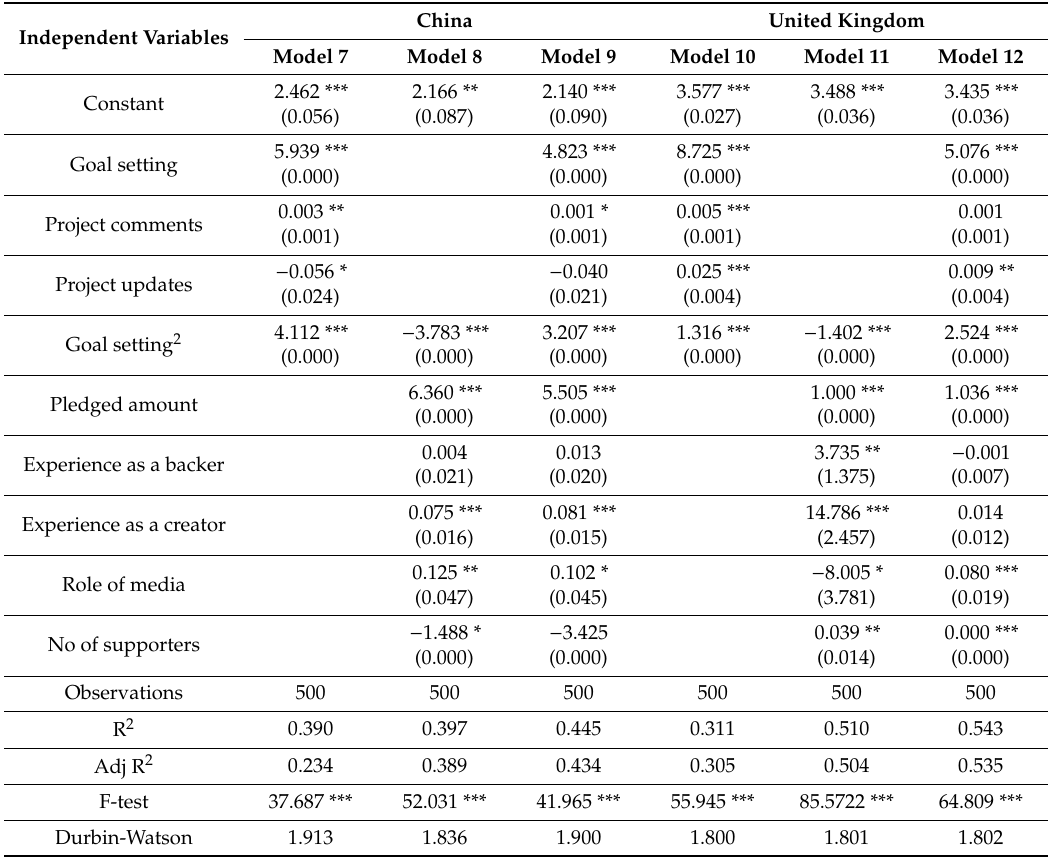
Table 5. Robustness results. Outcome variable: log